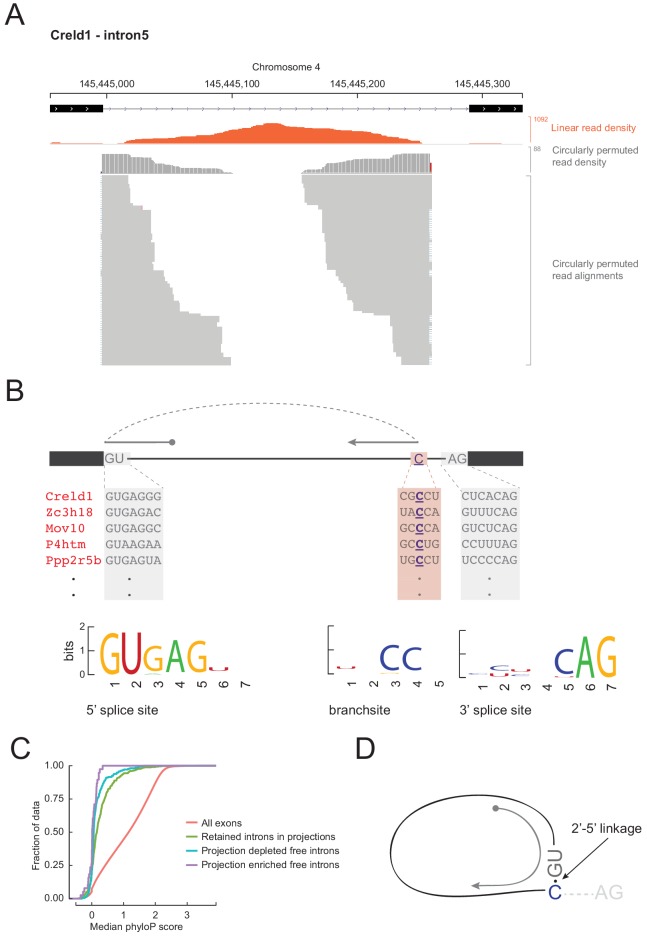
Free circular introns with a noncanonical branchpoint.(A) Projection RNAseq read density for linearly mapped (orange) and circularly permuted (gray) reads across Creld1 - intron5. Alignment mismatches at the junction of circularly permuted reads are colored. Individual circularly permuted read alignments are shown as horizontal gray bars, with each bar representing one read. (B) Schematic of circularly permuted read alignment and sequence composition at 5’ splice sites, branch sites (the branchpoint nucleotide is underlined), and 3’ splice sites of five example introns. (C) Cumulative distribution function plots for phyloP sequence conservation showing lack of conservation in projection-enriched free introns relative to exons, or even to retained introns. x-axis represents median phyloP score over a 50 nt sliding window with 10 nt step size. (D) Inferred molecular structure of projection-localized free circular introns.Figure 6—source data 1.Characteristics of circularly permuted read alignments on free introns.